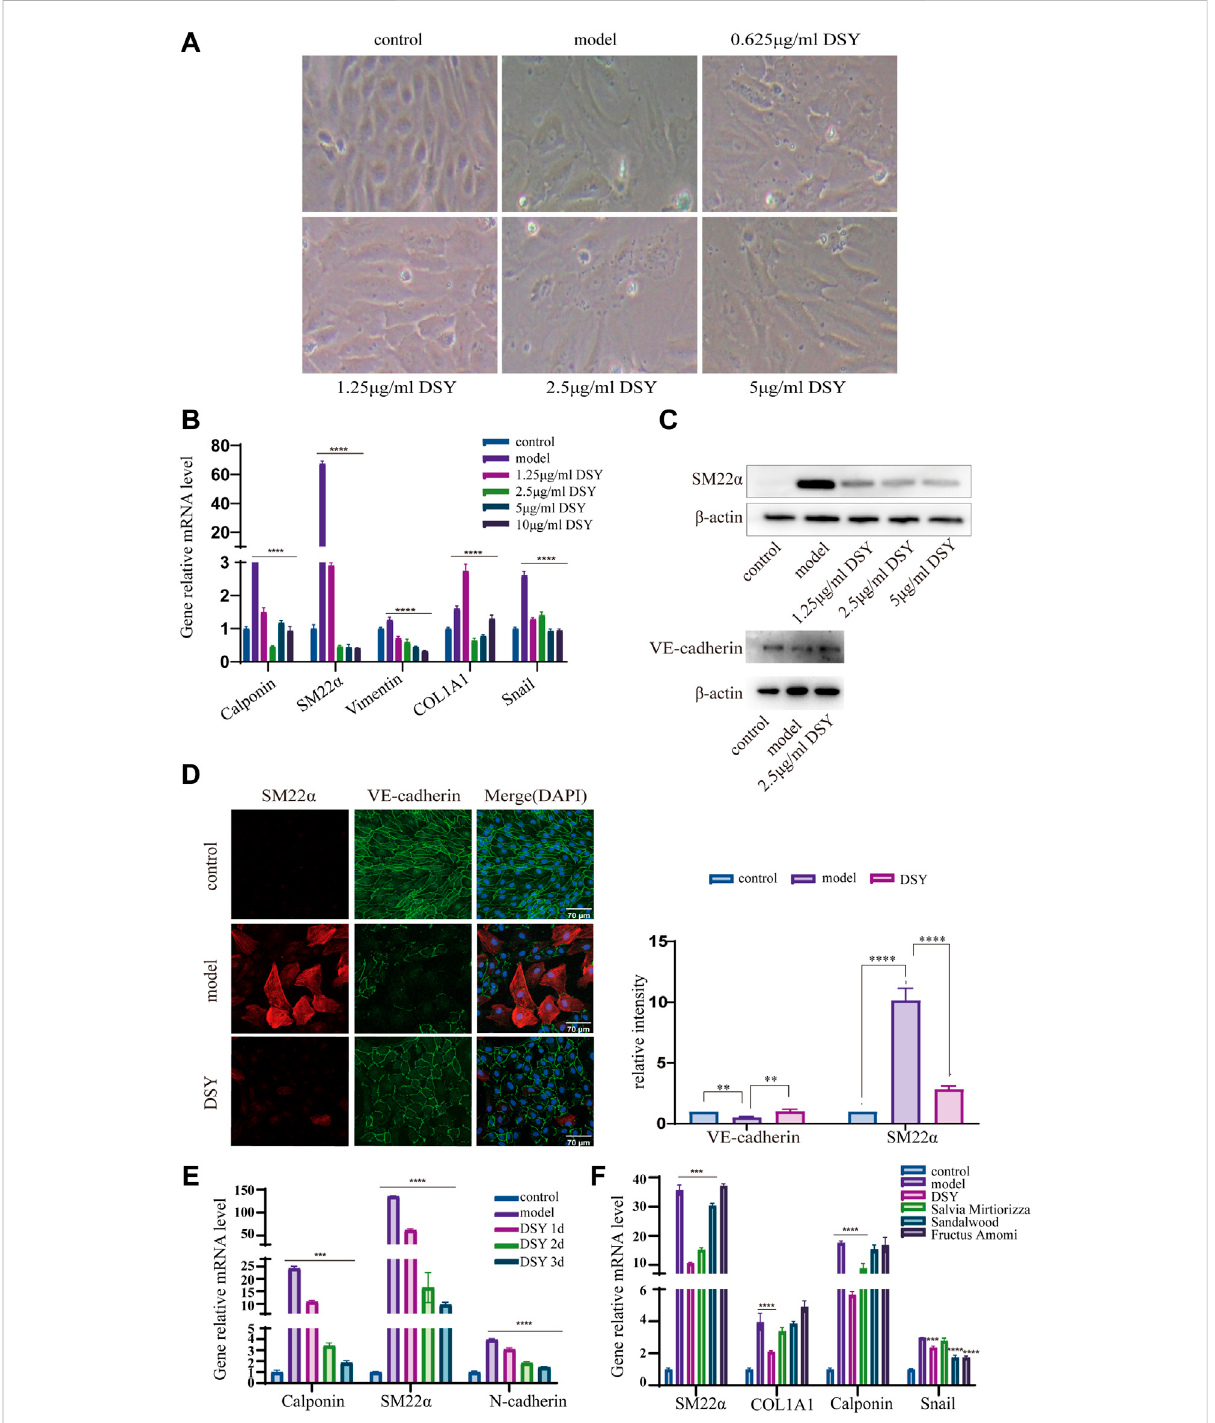
FIGURE 4 TheeffectofDSYonEndMT. (A – E) HUVECspretreatedwith10 ng/mlTGF- β 2for2 dayswereincubatedwithdifferentdosesofDSYforanother 2 d. (A) Representative phase contrast microscopy images. (B) RT-qPCR analysis of SM22 α , calponin, vimentin, COL1A1, and Snail. (C) Western blot analysis was conducted to detect SM22 α and VE-cadherin expression in DSY-treated cells. ( D, right panel ) Representative confocal images of HUVECs immune labeled with SM22 α and VE-cadherin. ( D, left panel ) Relative intensities of SM22 α and VE-cadherin were quanti fi ed by Fiji software. (E) HUVECs were pretreated with TGF- β 2 for 3, 2, and 1 day followed by stimulation with 2.5 μ g/ml DSY for another 1, 2, and 3 days. RT- qPCR analysis of SM22 α , calponin and N-cadherin was demonstrated. (F) HUVECs pretreated with 10 ng/ml TGF- β 2 for 2 days were treated with 2.5 μ g/ml DSY, Salvia miltiorrhiza , fructus amomi and sandalwood for another 2 days. RT-PCR analysis of SM22 α , calponin, COL1A1, and Snail was